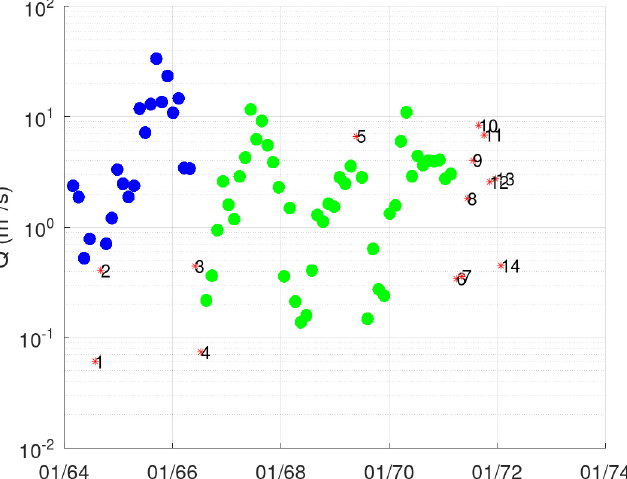
Figure 3. Sakoulevas case study—discharge time series plot. With different colours, the partition of DBSCAN. Period 1 (02/1964–04/1966) with blue dots, period 2 (05/1966–01/1972) with green dots, outliers with red stars.